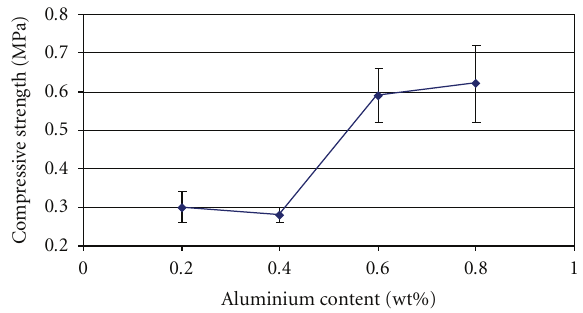
Figure 3: ACCC compressive strength as a function of aluminum content. The vertical bars represent the standard deviation of the measured values.